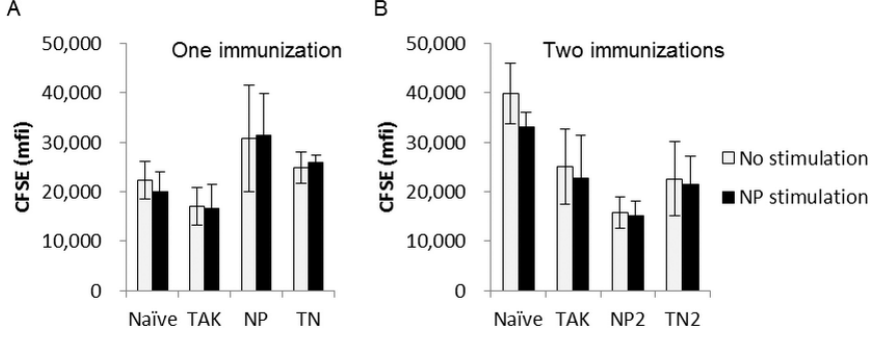
Figure 6. Proliferative ability of CD8 + T cells in NP-immunized mice with or without TAK-779 treatment compared with control group. Two weeks after TAK-779 cessation, splenocytes were prepared from individual spleens collected from naïve mice, mice treated with TAK-779 (TAK), mice immunized once (NP) or twice with NP (NP2) and mice immunized once (TN) or twice (TN2) with NP and treated with TAK-779. Proliferation was measured as mean fluorescence intensity (mfi) of CFSE by flow cytometry upon NP stimulation. (A) One NP immunization; (B) 2 NP immunizations. Results are expressed as the mean ± SD. The data are representative of 2 independent experiments with at least 4 mice per group. Mice were analyzed